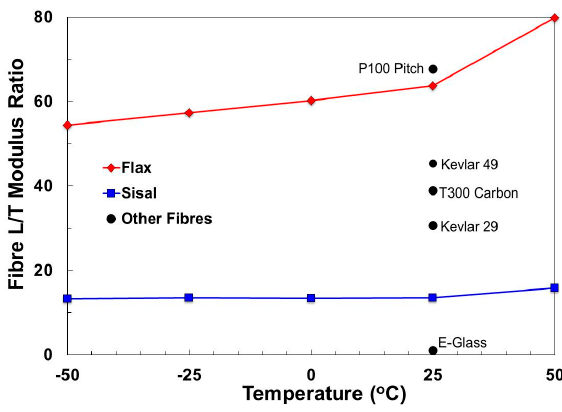
Figure 4. Comparison of the modulus anisotropy of natural fibres with other reinforcement fibres.